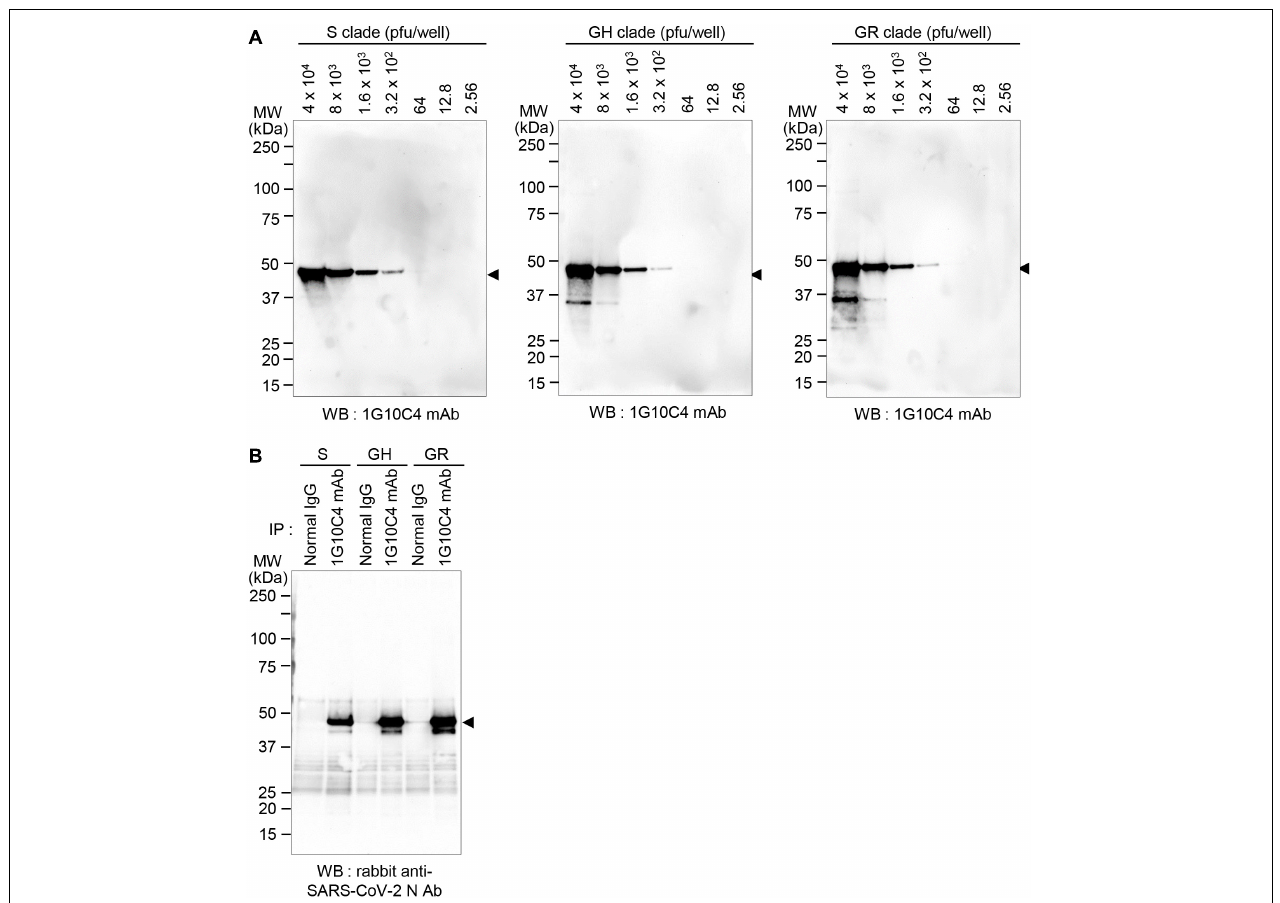
FIGURE 4 | Detection of N protein in SARS-CoV-2 S, GH, or GR clade virus particles with anti-SARS-CoV-2 N protein-specific monoclonal antibody. (A) Western blot analyses. Vero cells were infected with SARS-CoV-2 S, GH, or GR clade at a MOI of 0.01 for 72 h and then cell culture supernatants were collected. The cell culture supernatants were lysed with cell lysis buffer and analyzed by western blotting with the anti-SARS-CoV-2 N protein-specific monoclonal antibody (clone 1G10C4 mAb). Virus titers were measured by plaque assay. (B) Immunoprecipitation analysis. Vero cells were infected with SARS-CoV-2 S, GH, or GR clade at a MOI of 0.01 for 72 h and then cell culture supernatants were collected. The cell culture supernatants were lysed with cell lysis buffer and immunoprecipitated with normal mouse IgG or the anti-SARS-CoV-2 N protein monoclonal antibody (clone 1G10C4 mAb). The immunocomplexes were subjected to western blot analysis using rabbit anti-SARS-CoV-2 N protein antibody (Catalog No. 40588-T62; Sino